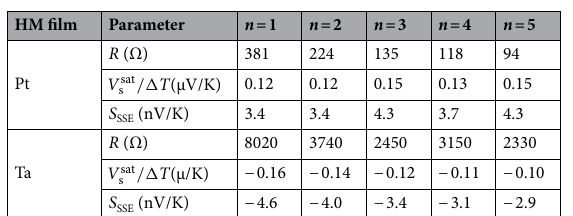
Table 1. Comparisons of resistance R , V Seebeck voltage